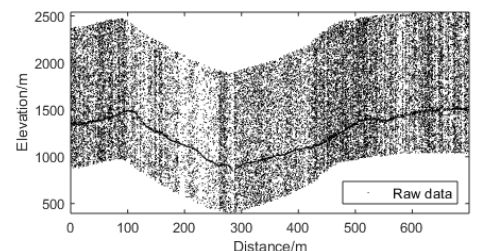
Fig 2. Profile of raw data, the x-coordinate is the distance along the track, and the y-coordinate is the elevation